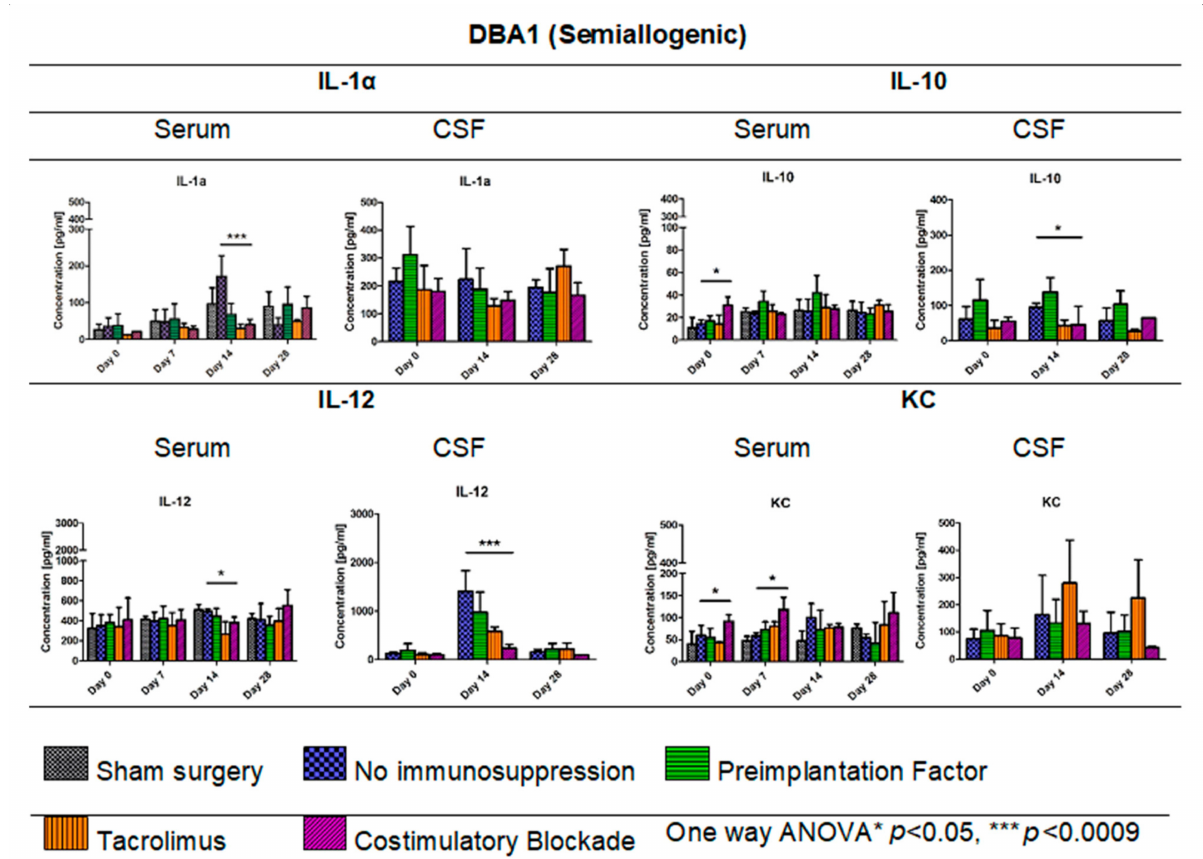
Figure 8. Cytokine levels in serum and CSF of DBA1 semiallogenic model: IL-1 α , IL-10, IL12, and KC levels in serum and CSF samples were measured in semiallogenic DBA1 mice. There were significant differences between variants of the immunomodulatory regime in the level of IL-1 α observed on day 14 ( p < 0.0009). Significant differences were also found between the studied variants in serum samples for IL-10 (day 0, p < 0.05), IL-12 (day 14, p < 0.05), and KC levels (days: 0 and 7, p < 0.05). Significant differences in cytokine level in CSF were observed for IL-10 ( p < 0.05) and IL-12 ( p < 0.0009) on day 14 post-transplantation. Unpaired Student’s t -test; data are presented as mean, error bars: SD; the total number of samples: n = 77, total number per variant at each time point: n = 3–5. The total number of biological replicates per group: n = 5. Abbreviations: CSF-cerebrospinal